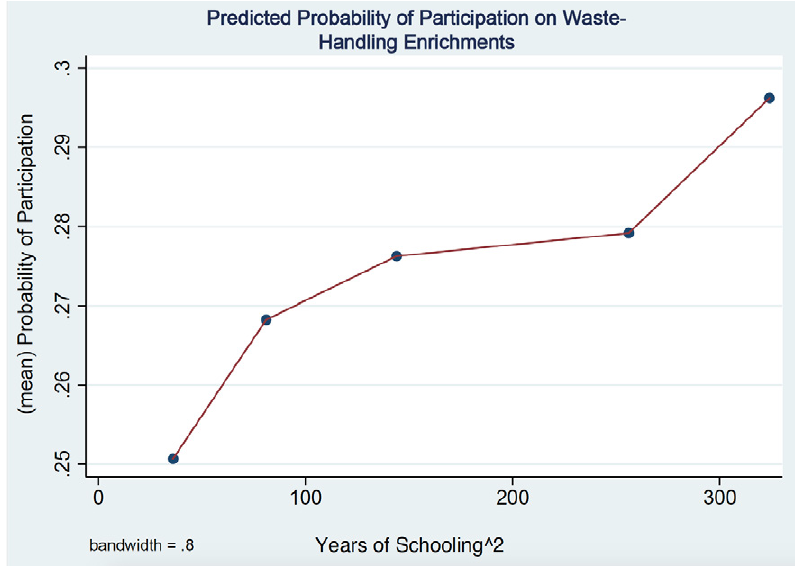
Fig. 4: The squared years of schooling in this case do not have quadratic relationship to the probability of participations.